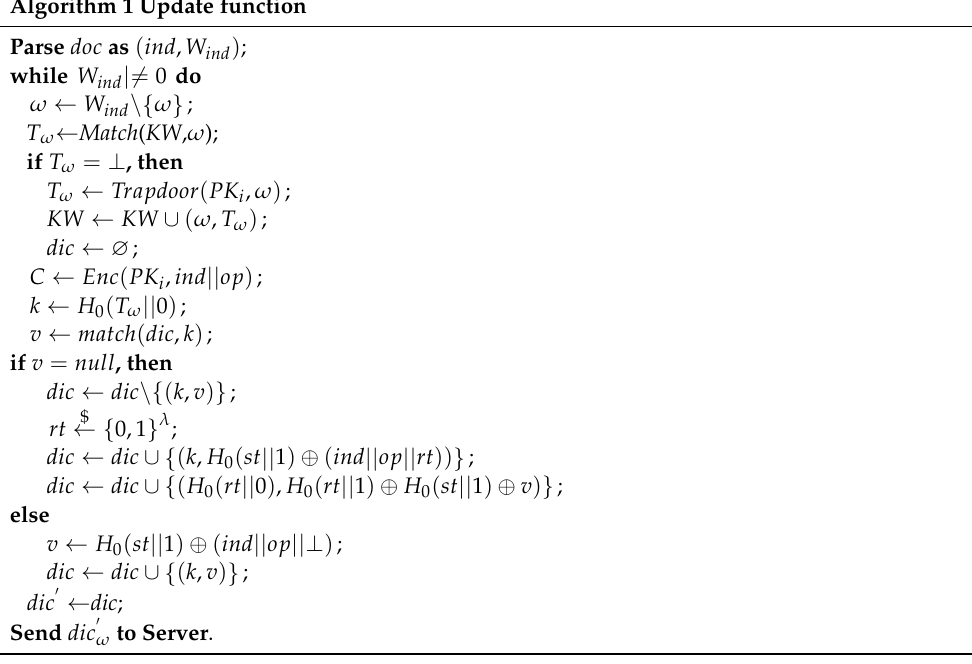
Algorithm 1 Update function